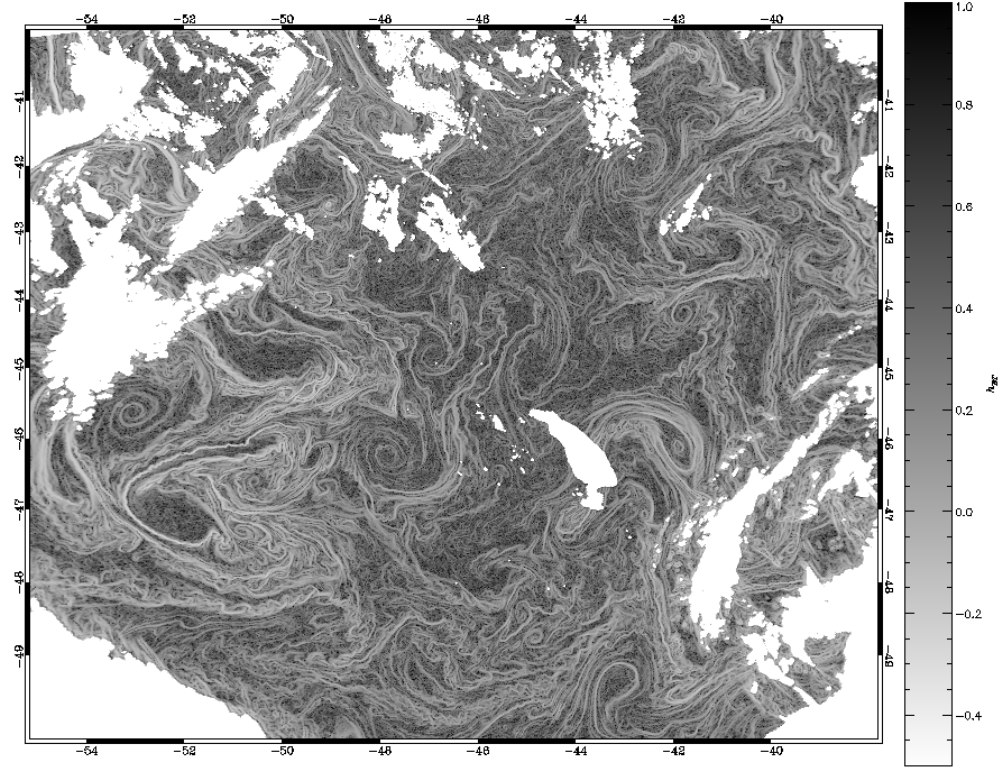
Figure 7. Singularity exponents derived from the brightness temperature of the image shown in Fig.